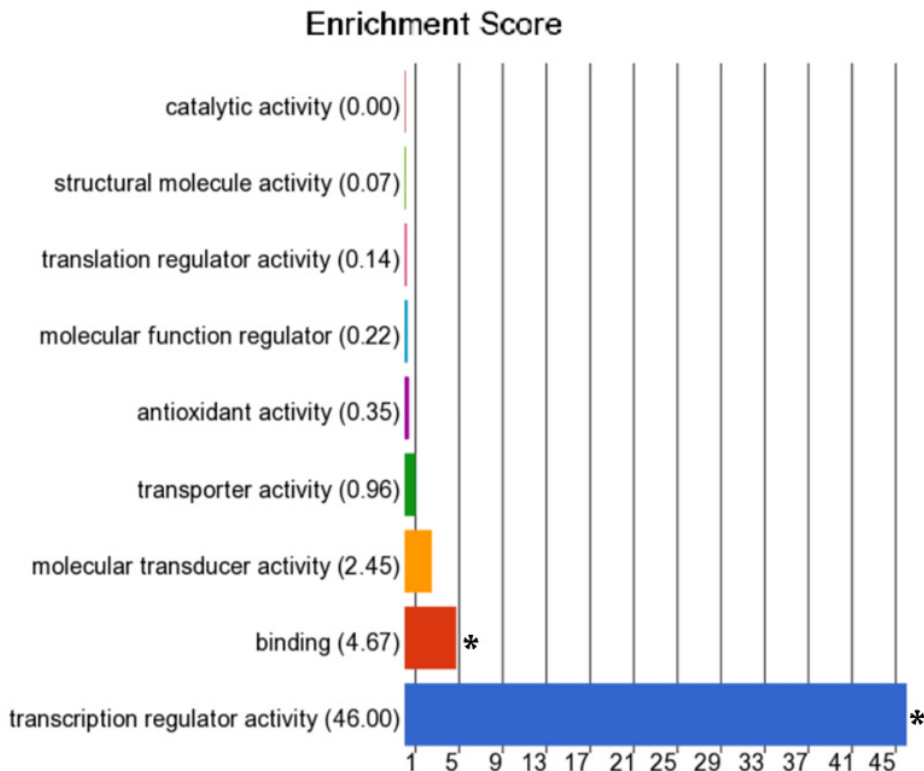
Figure 3. Molecular function of the differentially methylated genes, derived from Gene-Ontology. The x-axis indicates the enrichment scores, and the y-axis indicates the molecular functions. Enrichments that are statistically significant ( p -value < 0.05) are indicated with asterisks.